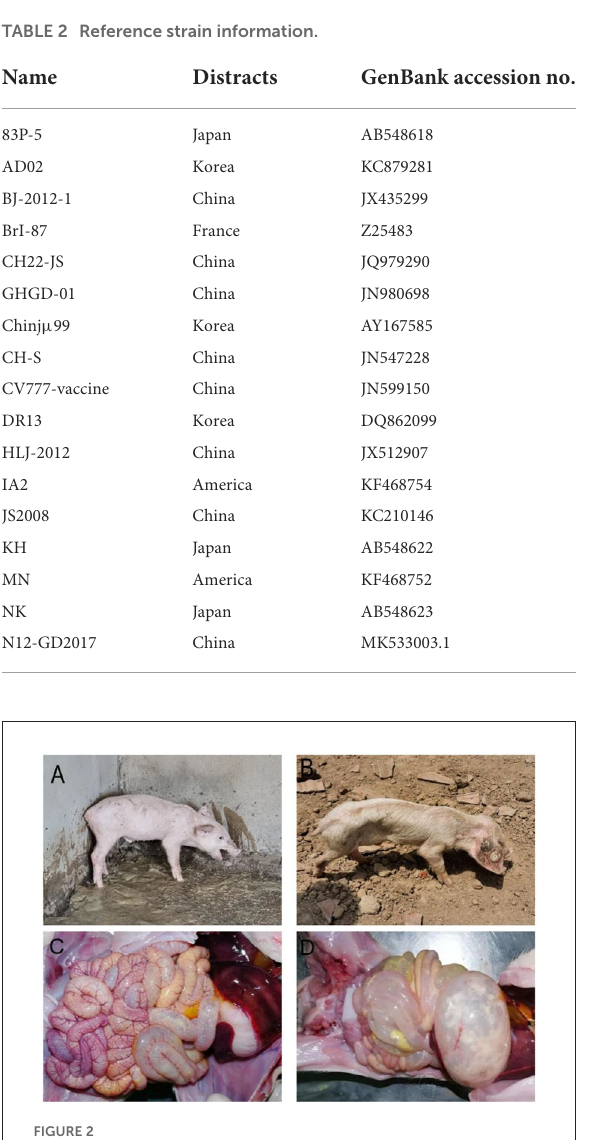
FIGURE2 Clinical symptoms and pathological change. (A) Diarrhea accompanied by vomiting; (B) Dehydration and emaciation; (C) Intestinal mucosa and mesenteric hyperemia and bleeding; (D) The intestinal wall is clear and filled, and the stomach is dilated.